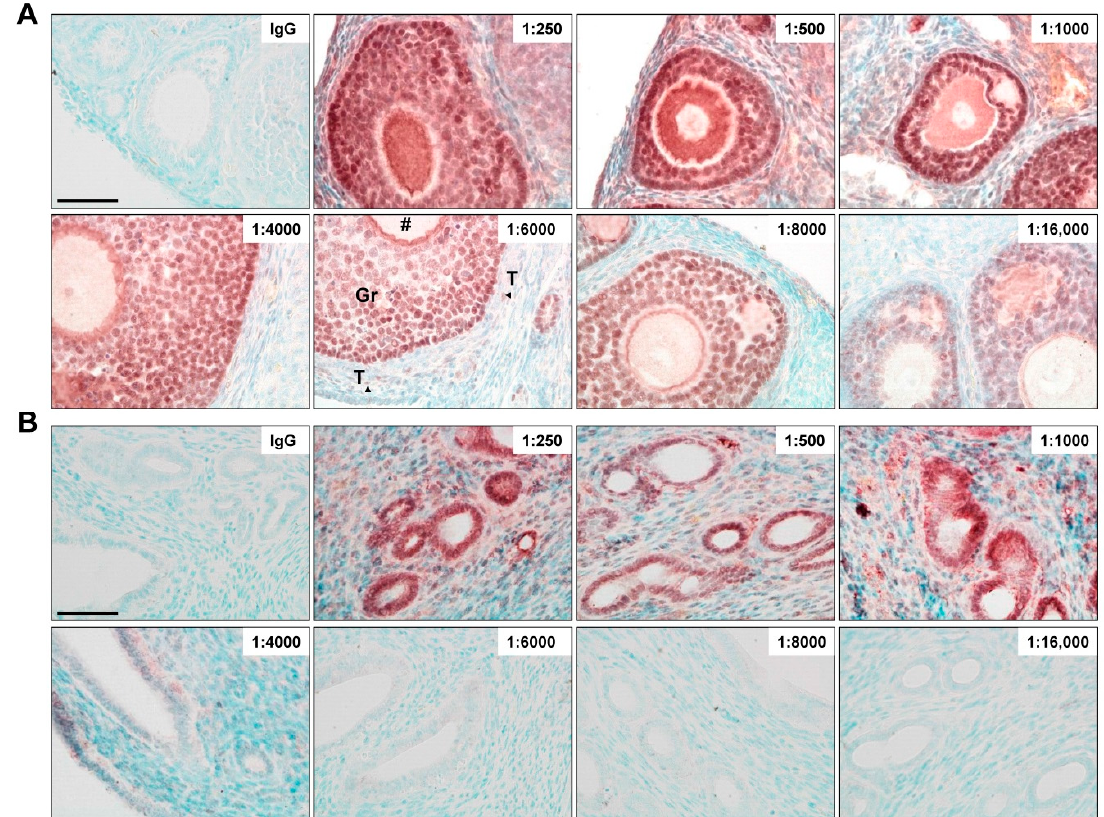
Figure 4. Titration of PPZ0506 primary antibody. Paraffin-embedded sections were chosen for immunohistochemical detection of nuclear expressed estrogen receptor beta (ER β ). The antibody (PPZ0506; 1 mg/mL) was diluted to obtain optimal dilution ratio (as indicated) in ovaries ( A ) or uterus ( B ). For negative control, IgG isotope staining was performed with a concentration equivalent to primary antibody dilution (1:8000). Cell types of the ovary are indicated as: Gr, granulosa cells; T (arrowheads), theca cells; #, oocyte cells. Please note that the murine uterus tissue was negative for ER β . Scale bar 50 µm (400×).